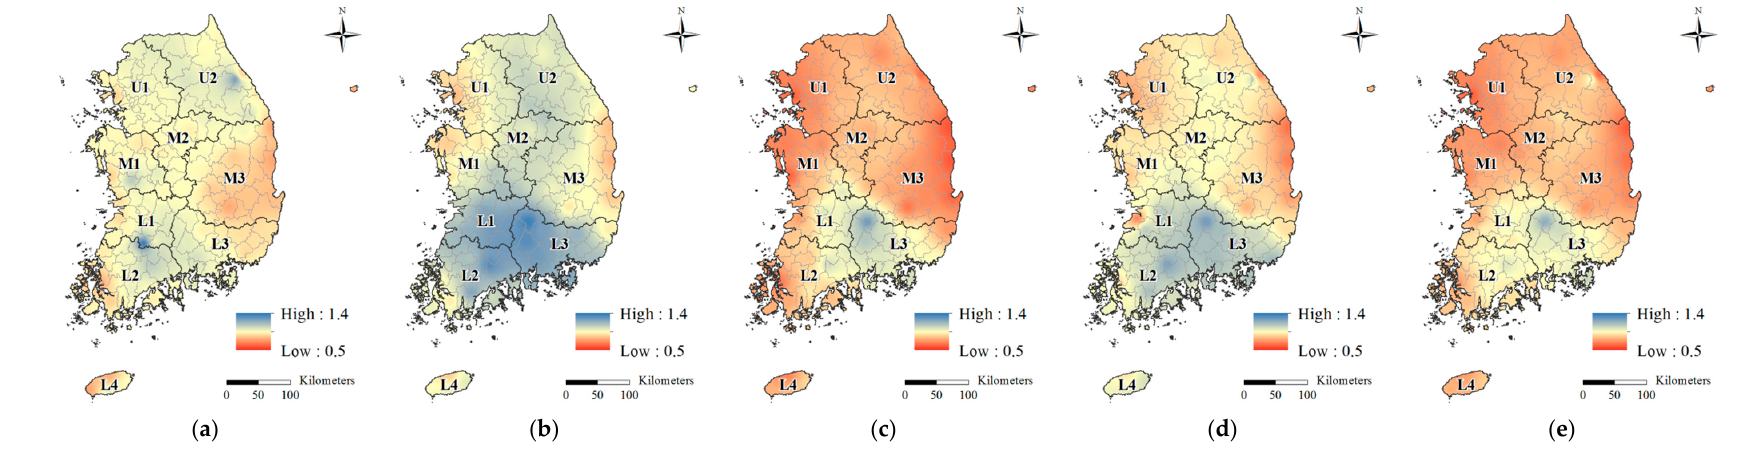
Figure 6. Spatial distribution of the REIP under different RCP Scenarios: ( a ) distribution of average REIP during the baseline period (1971–2010); ( b ) the 2060s with the most favorable REIP under the RCP 4.5 scenario; ( c ) the 2090s with the least favorable REIP under the RCP 4.5 scenario; ( d ) the 2040s with the most favorable REIP under the RCP 8.5 scenario; and ( e ) the 2060s with the least favorable REIP under the RCP 8.5 scenario.